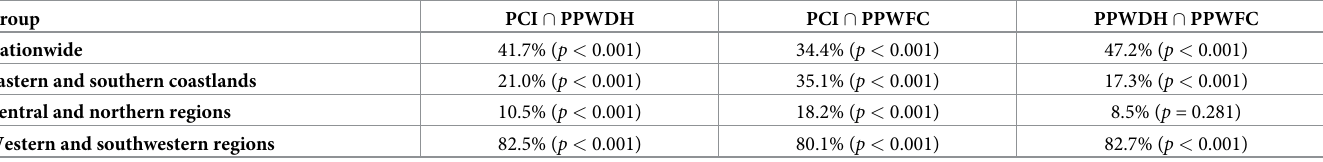
Table 4. GeoDetector q -statistics value (F test value) for the influencing power of interacting factors at the county level in China’s eastern and southern coastlands, central and northern regions, and western and southwestern regions.